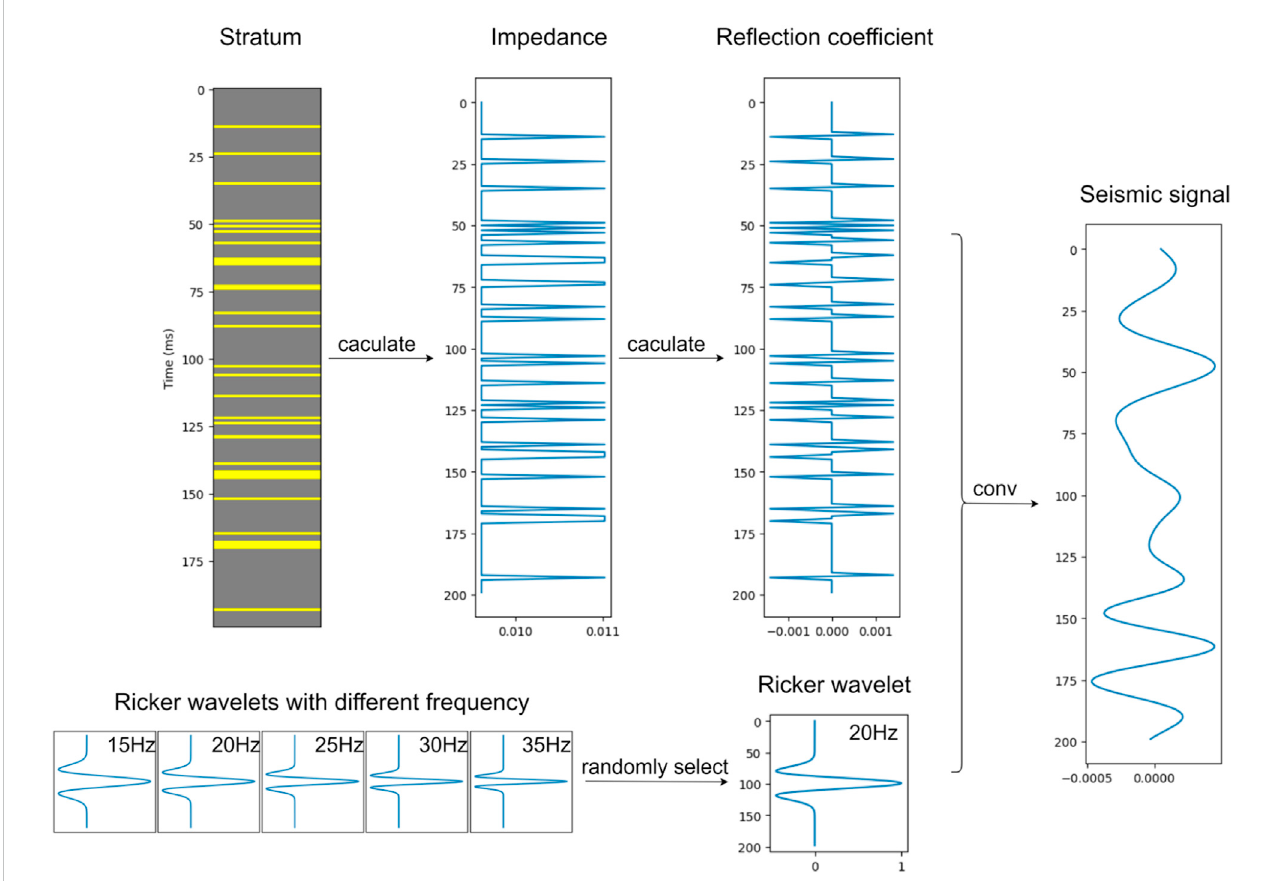
FIGURE 1 The work fl ow of creating synthetic seismic signals according to the convolution model for training and validation.